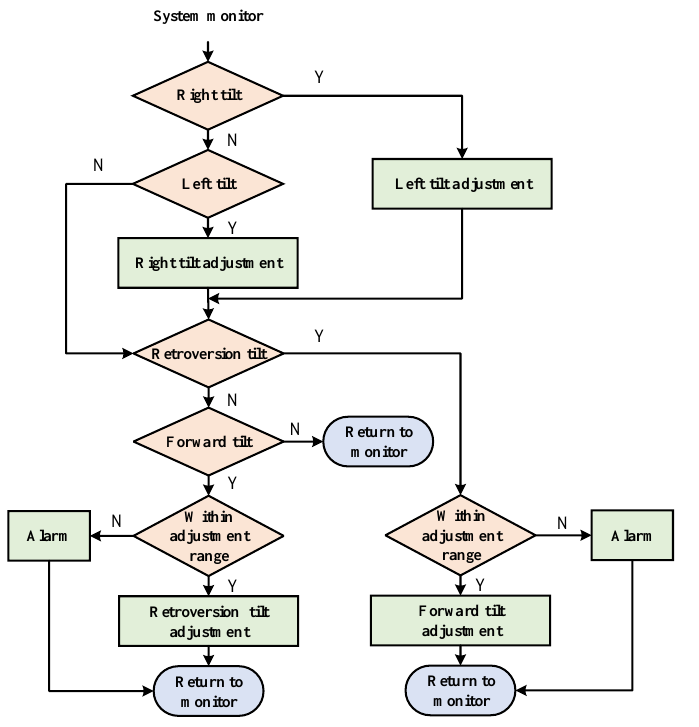
Figure 7. Automatic posture leveling sequence. Y means yes; N means no.